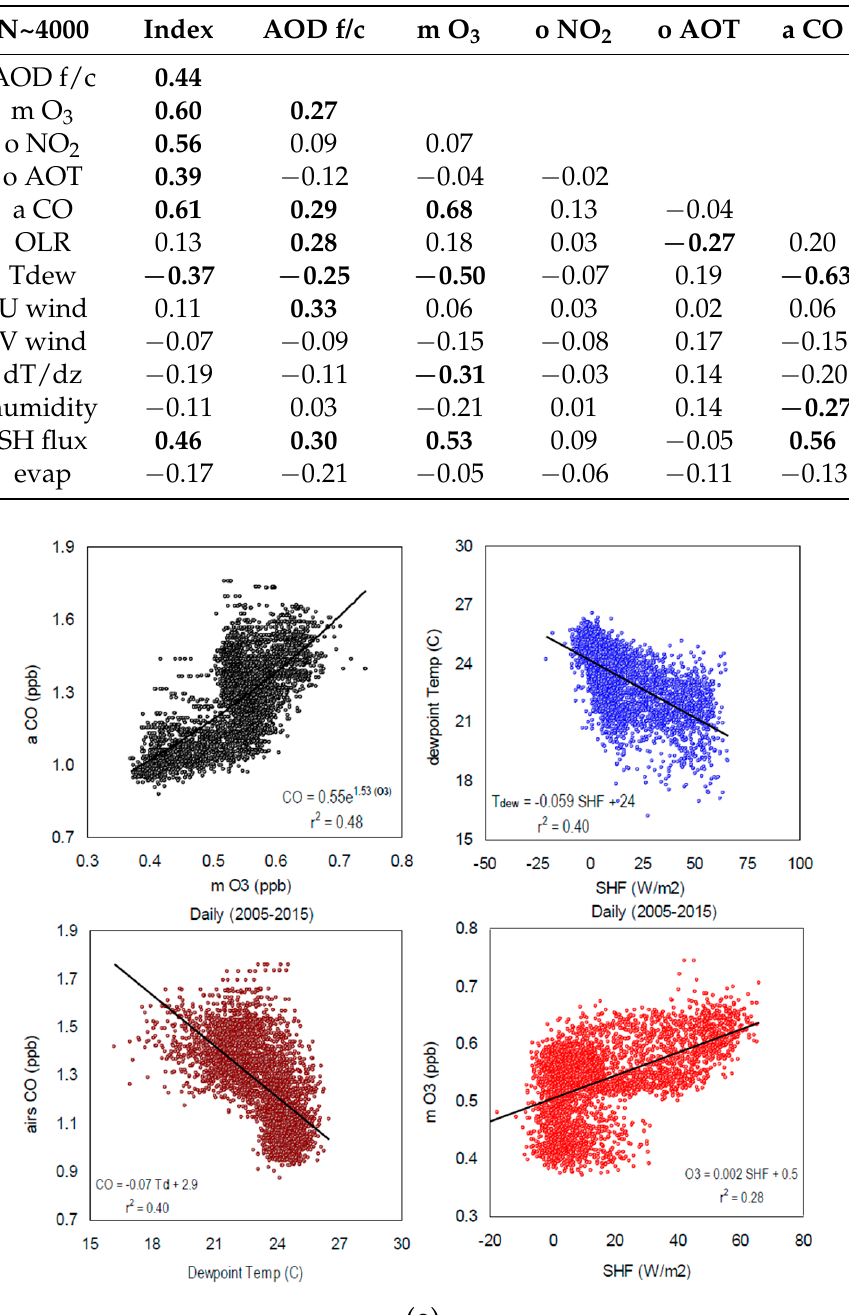
Table 3. Pair-wise correlation of daily air index, individual constituents and weather variables averaged over Puerto Rico (2005–2015); bold >90% confidence. Data sources are denoted m = MERRA2, o = OMI, a = AIRS, AOD f/c = in-situ AERONET, OLR = satellite, weather variables from MERRA2 include: Tdew = dewpoint temperature, U V wind = zonal and meridional components, dT/dz = T850–T1000 hPa, humidity = 850 hPa specific hum., SH flux = sensible heat flux, evap = latent heat flux.